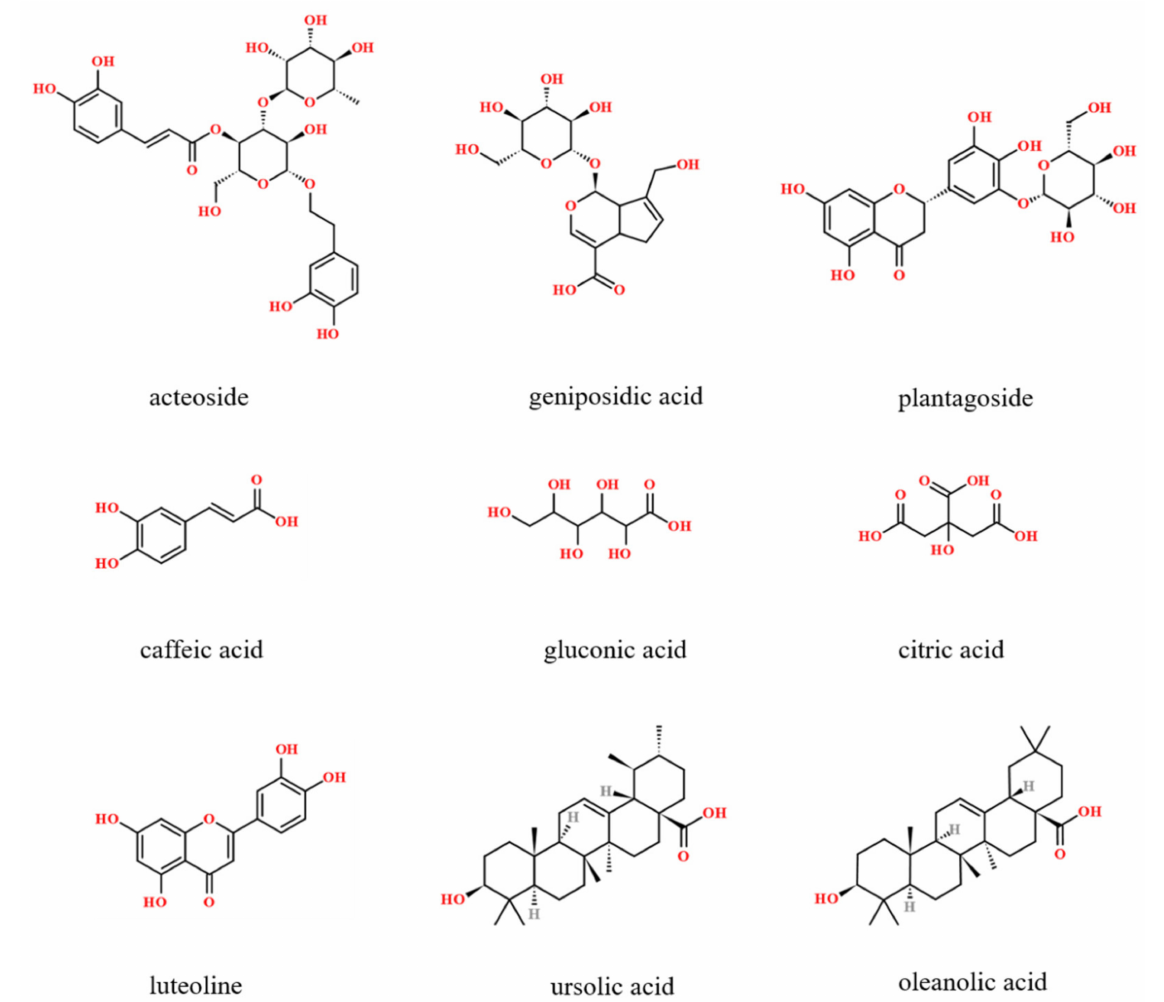
Figure 9. Chemical structures of the reference